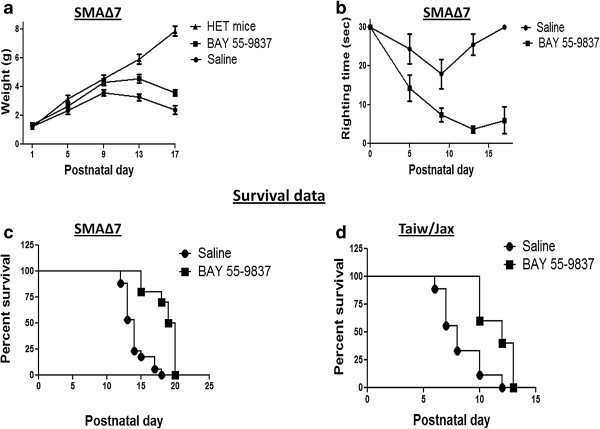
BAY 55-9837 ameliorates disease phenotype and increases survival of SMA mouse models. SMA∆7 mice were treated daily with intraperitoneal injections of BAY 55-9837 (200.0 μg/kg) from P1 onward. (a) Weights of SMA∆7 mice treated with BAY 55-9837 (black filled square, n =10) or saline (black filled circle, n =10); weights for heterozygous mice treated with saline (black filled triangle, n =5) are also shown for comparison [mean ± SEM (bars)]. (b) Righting times of SMA∆7 mice treated with BAY 55-9837 (black filled square, n = 10) or saline (black filled circle, n =10) [mean ± SEM (bars)]. (c) Kaplan-Meier survival curves of SMA∆7 mice treated with BAY 55-9837 (black filled square, n = 10; median survival 19.5 days) or saline (black filled circle, n =17; median survival 14.0 days ). (d) Kaplan-Meier survival curves of Taiwanese-SMA mice treated with BAY 55-9837 (black filled square, n = 5; median survival 12.0 days) or saline (black filled circle, n =10; median survival 8.0 days); *P < 0.05; ***P < 0.0001, log-rank test.